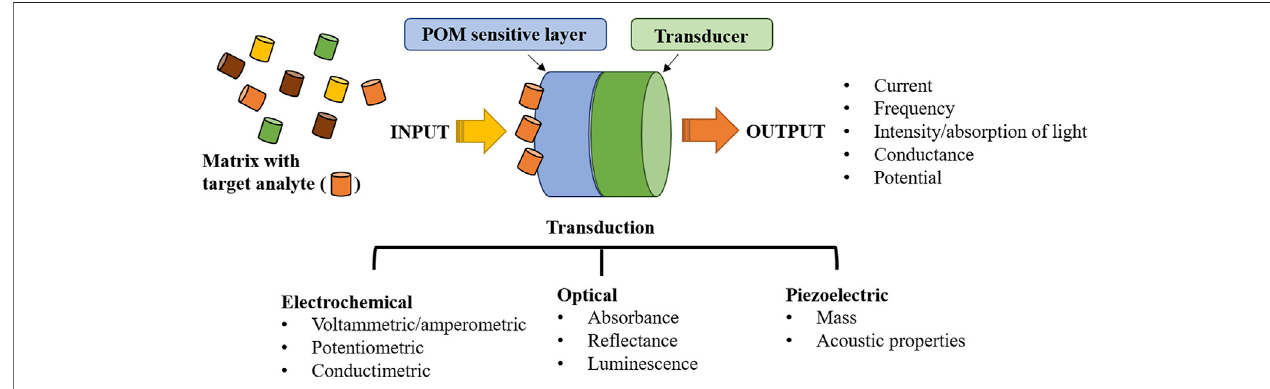
FIGURE 3 | Overview of the sensor composition: from polyoxometalate analyte recognition layer to the transducer and measured signal.